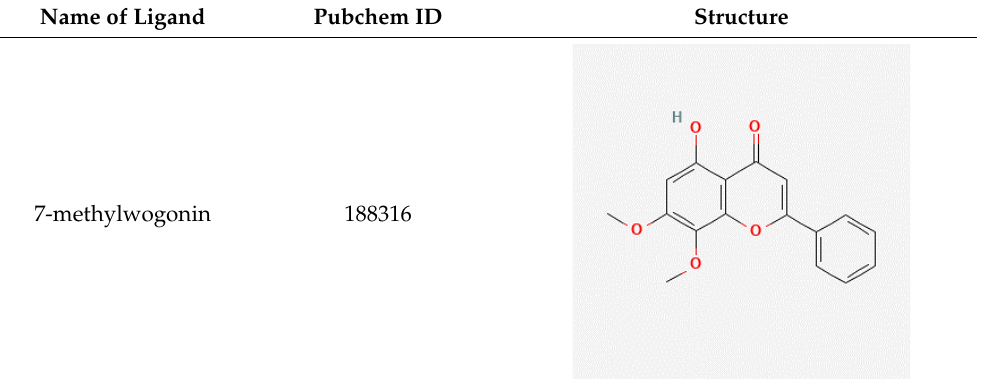
Table 5. 2D Structures of ligands.